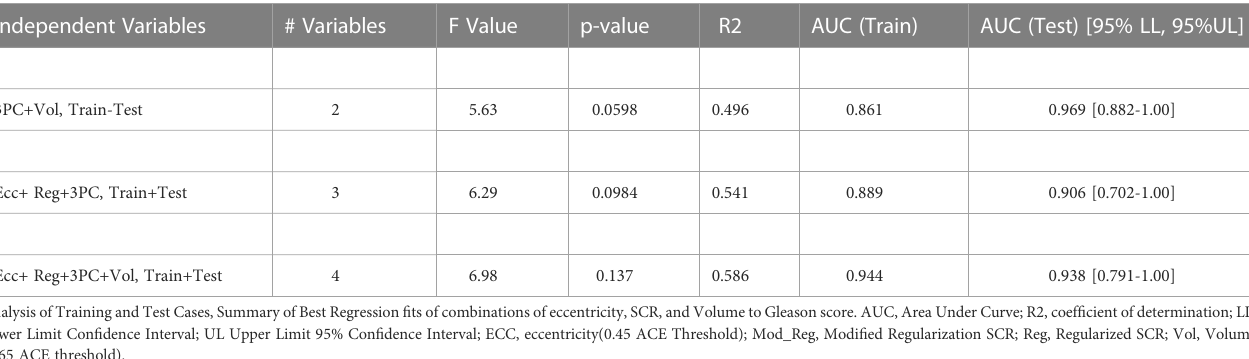
TABLE 2 Summary of Logistic Regression fi ts for Training, Test Sets. Independent Variables